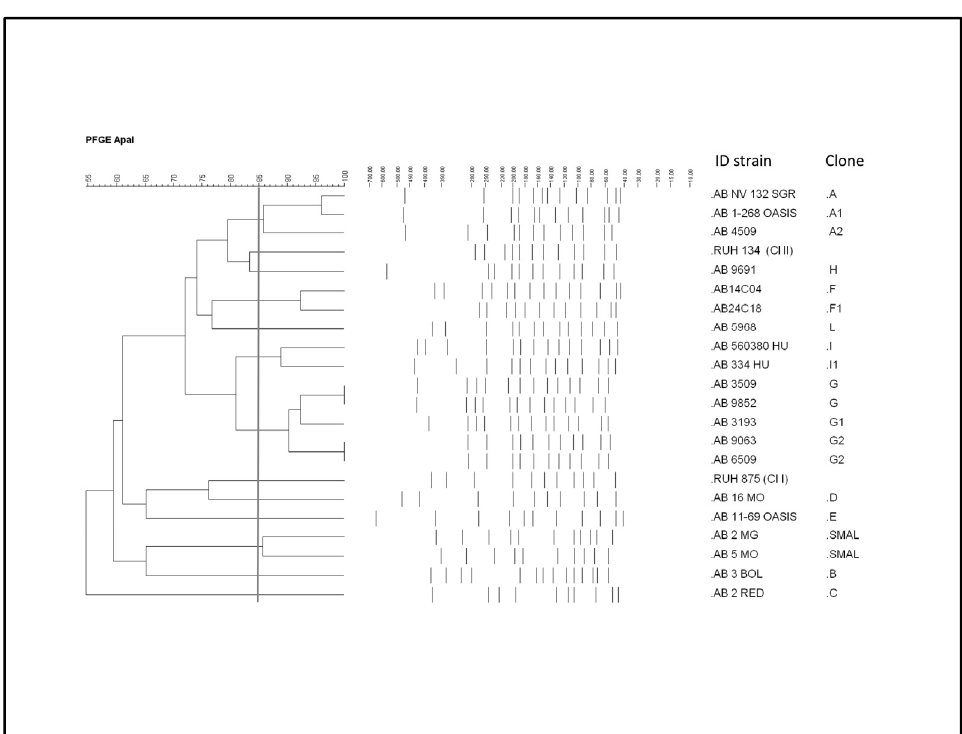
Figure 2. Cluster analysis of the pulsed-field gel electrophoresis profiles of the Acinatobacter baumannii strains included in the study.